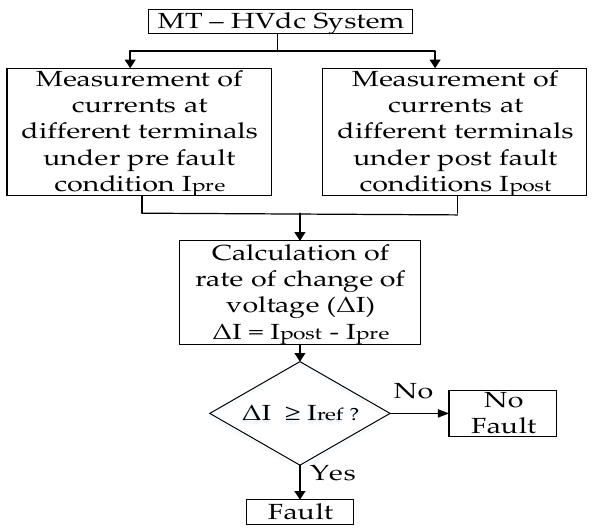
Figure 23. Non-traveling wave (NTW) method based on rate of change of current.